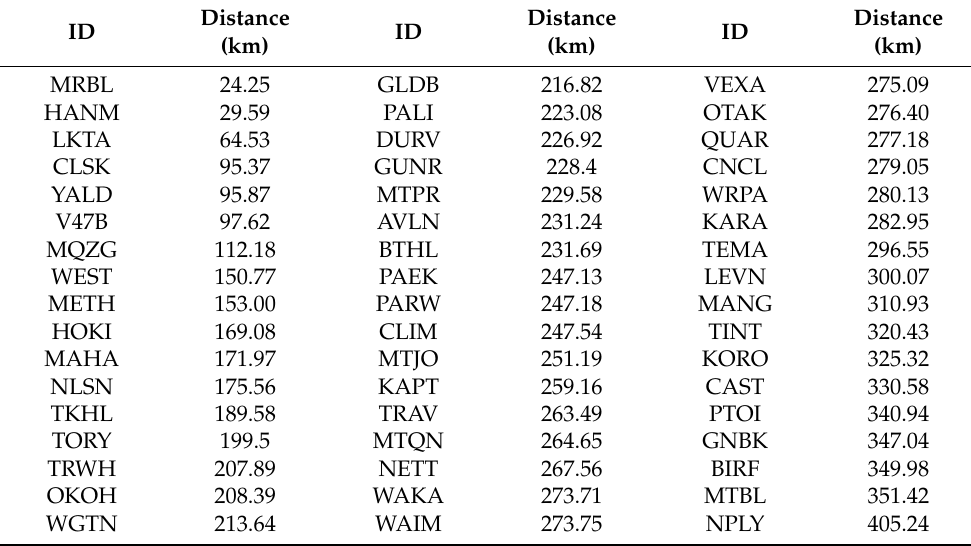
Table 4. The epicentral distances of the selected GPS